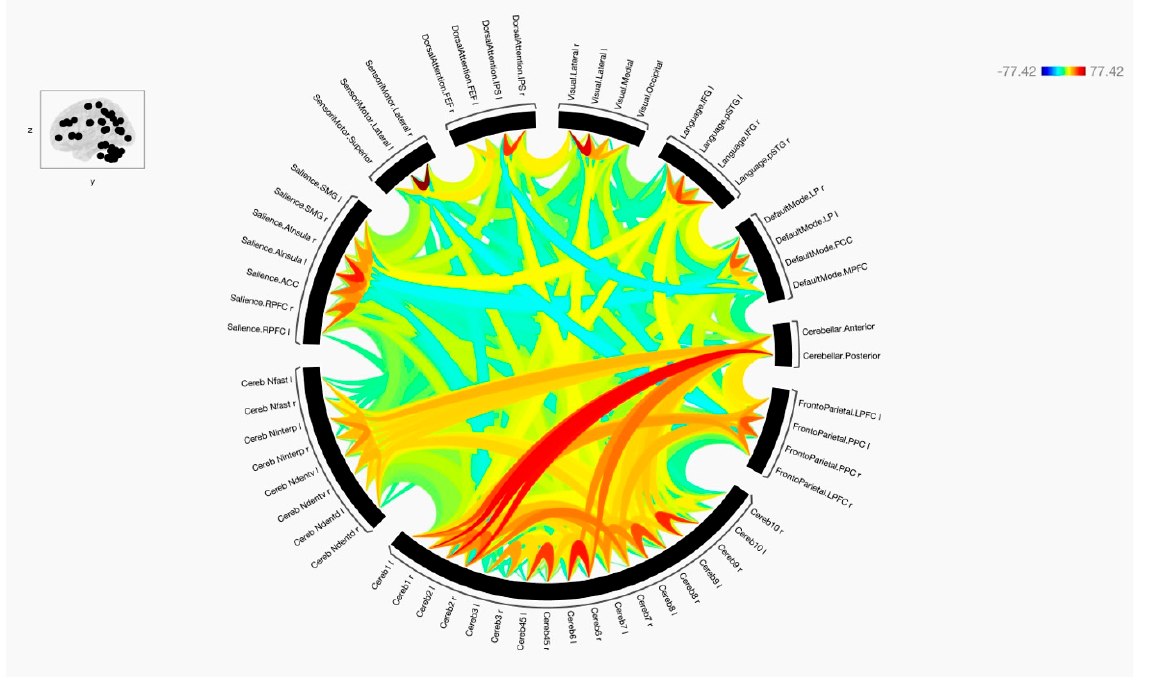
Figure 1. The functional connectivity of the selected seeds and target regions is shown at the group level. The lines of the connections in red indicate positive connectivity, while blue indicates negative connectivity. The colors of the lines are proportional to statistical strength, and the T-bar is shown in the top right-hand corner.